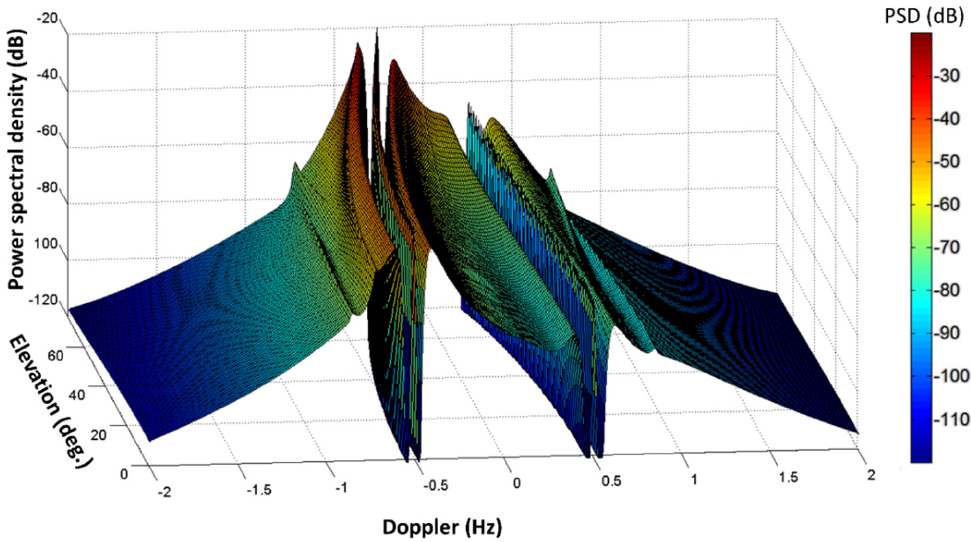
Figure 10. Modelled clutter Doppler spectra for a specified sea state, varying only the elevation